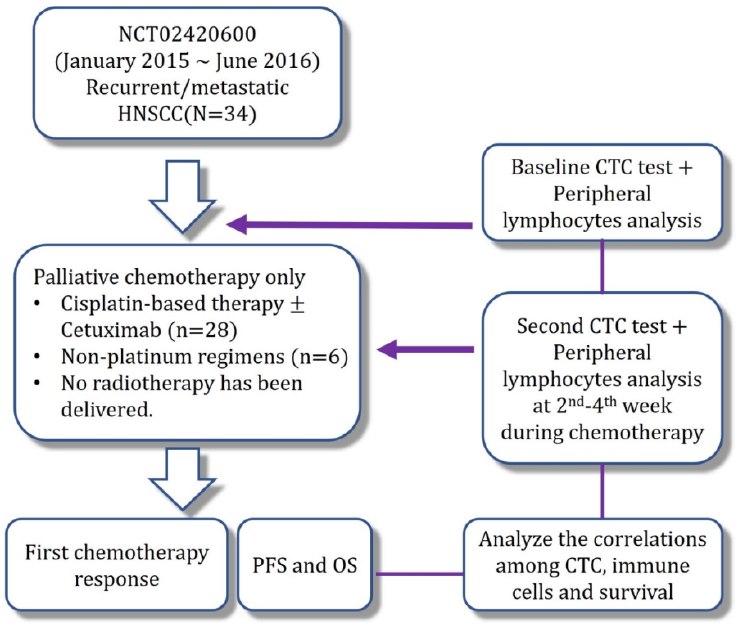
Figure 1. Study flow chart.